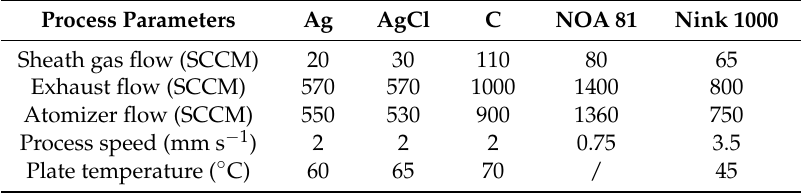
Table 1. Printing process parameters.